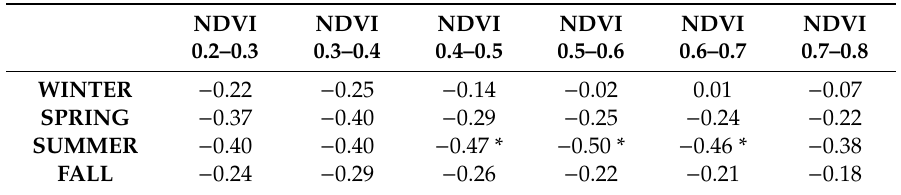
Table 5. The correlation between seasonal DA with seasonal spatial coverage of di ff erent NDVI categories in Afghanistan between 2001 and